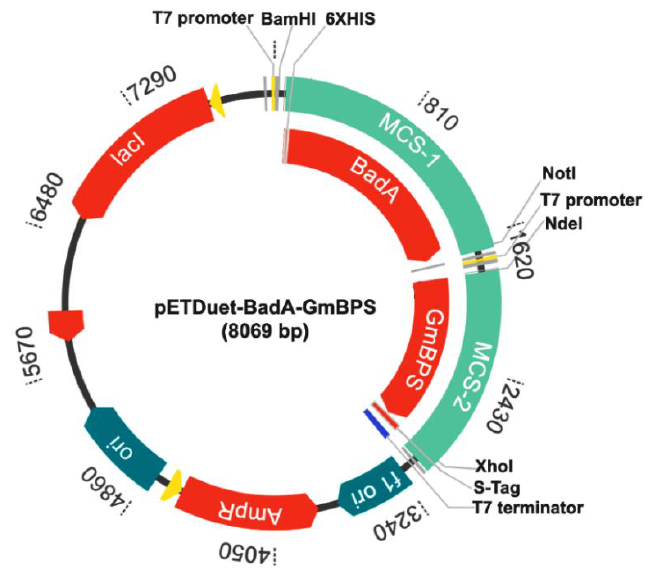
Figure 8 . The recombinant plasmid pETDuet - BadA - GmBPS